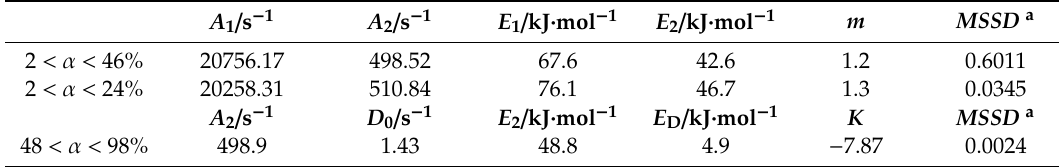
Table 3. Parameters obtained by fitting Equations (18) and